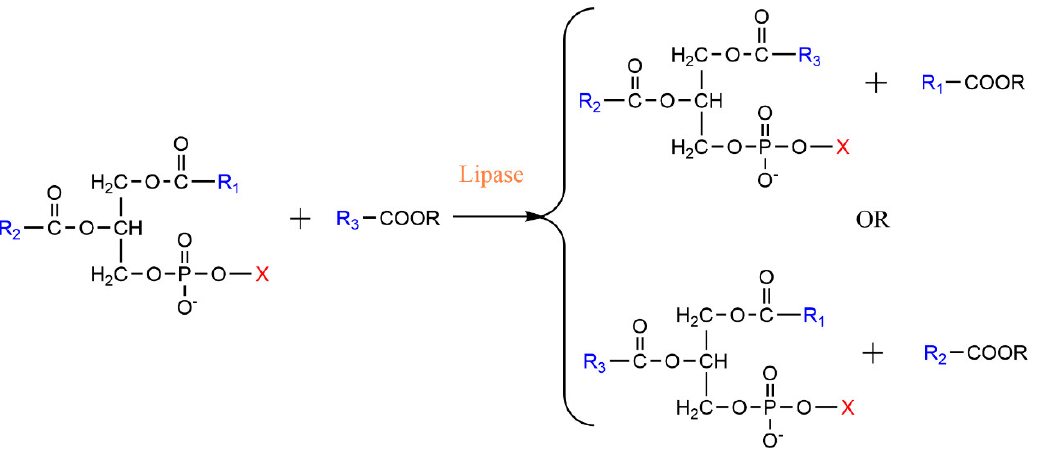
Figure 5. Lipase−catalyzed transesterification for SPLs preparation. Transesterification occurs be- Figure 5. Lipase − catalyzed transesterification for SPLs preparation. Transesterification occurs tween two esters, resulting in an exchange of acyl groups. between two esters, resulting in an exchange of acyl groups.